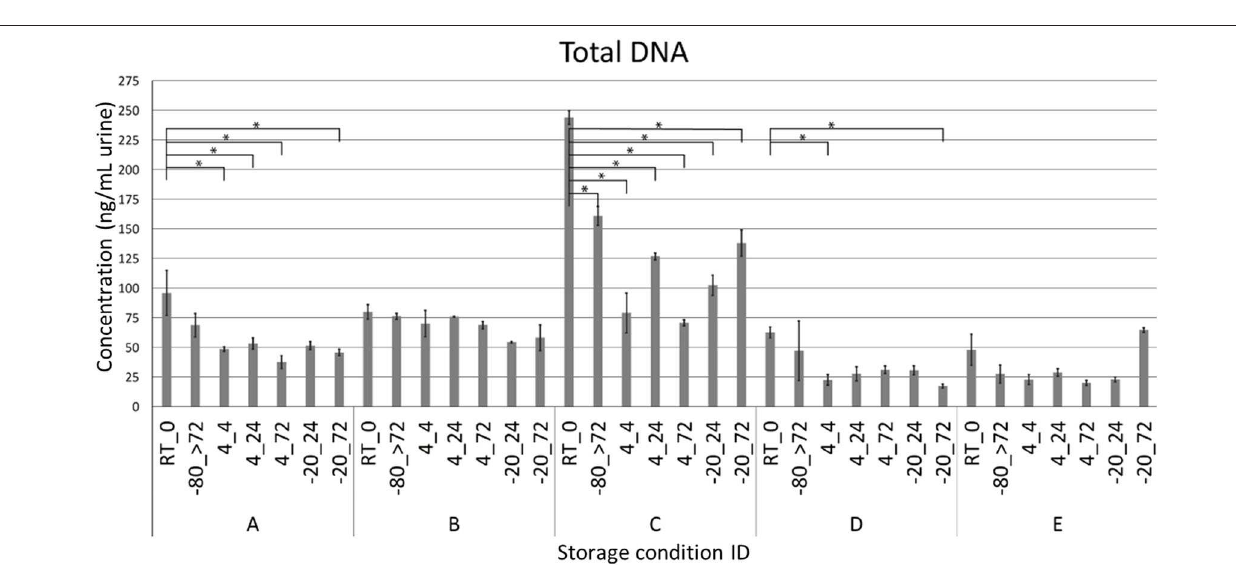
freshly processed sample, followed by samples stored directly at − 80 ◦